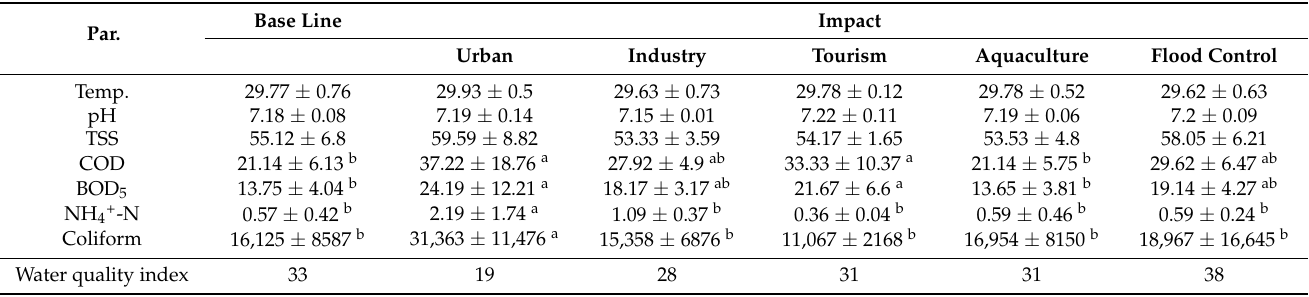
Table 2. Mean value of surface water quality by water